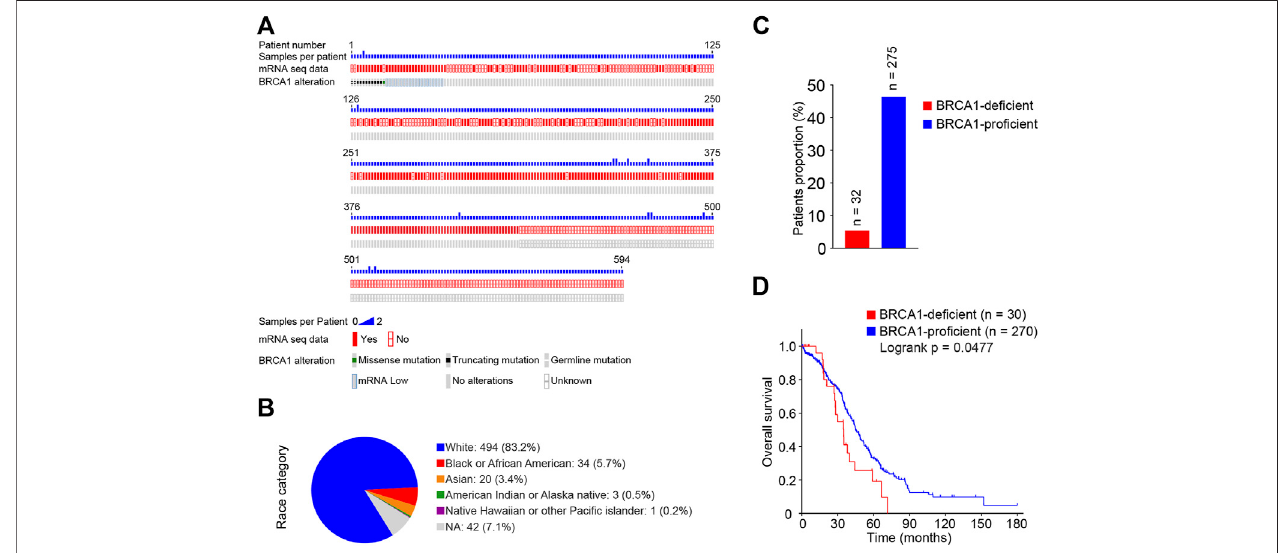
FIGURE1| SurvivalanalysisofBRCA1-de fi cientovariancancerpatientsfromTCGAdatabase. (A) BRCA1 mutationsandmRNAtranscriptomeinformationplotof ovariancancerpatientsfromTCGAdatabasedownloadedfromthecBioPortal.Atotalof606samplesfrom594ovariancancerpatientsinthedatasetwererecorded. (B) Race category of ovarian cancer patients from (A) . Of the 594 patients 83.2% were Caucasian, 5.7% were African American, 3.4% were Asian. (C) Proportions of BRCA1-de fi cient (mutated and mRNA low) and -pro fi cient (wild-type and mRNA normal) patients. 32 BRCA1-de fi cient, 275 BRCA1-pro fi cient were included. (D) Kaplan-MeiersurvivalcurveofoverallsurvivalbetweenBRCA1-de fi cientpatients( n =30,red)andBRCA1-pro fi cientpatients( n =270,blue).Patientswithrelatedclinical information were included. LogRank p =